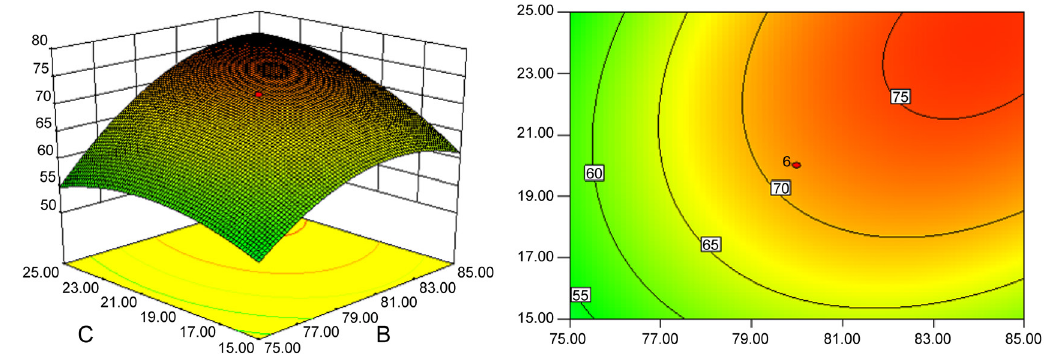
Figure 10: Response surface figure and contour map of eluent concentration (B) and eluent volume (C). The range of B is from 75 to 80%, and the range of C is from 15 to 25 BV.